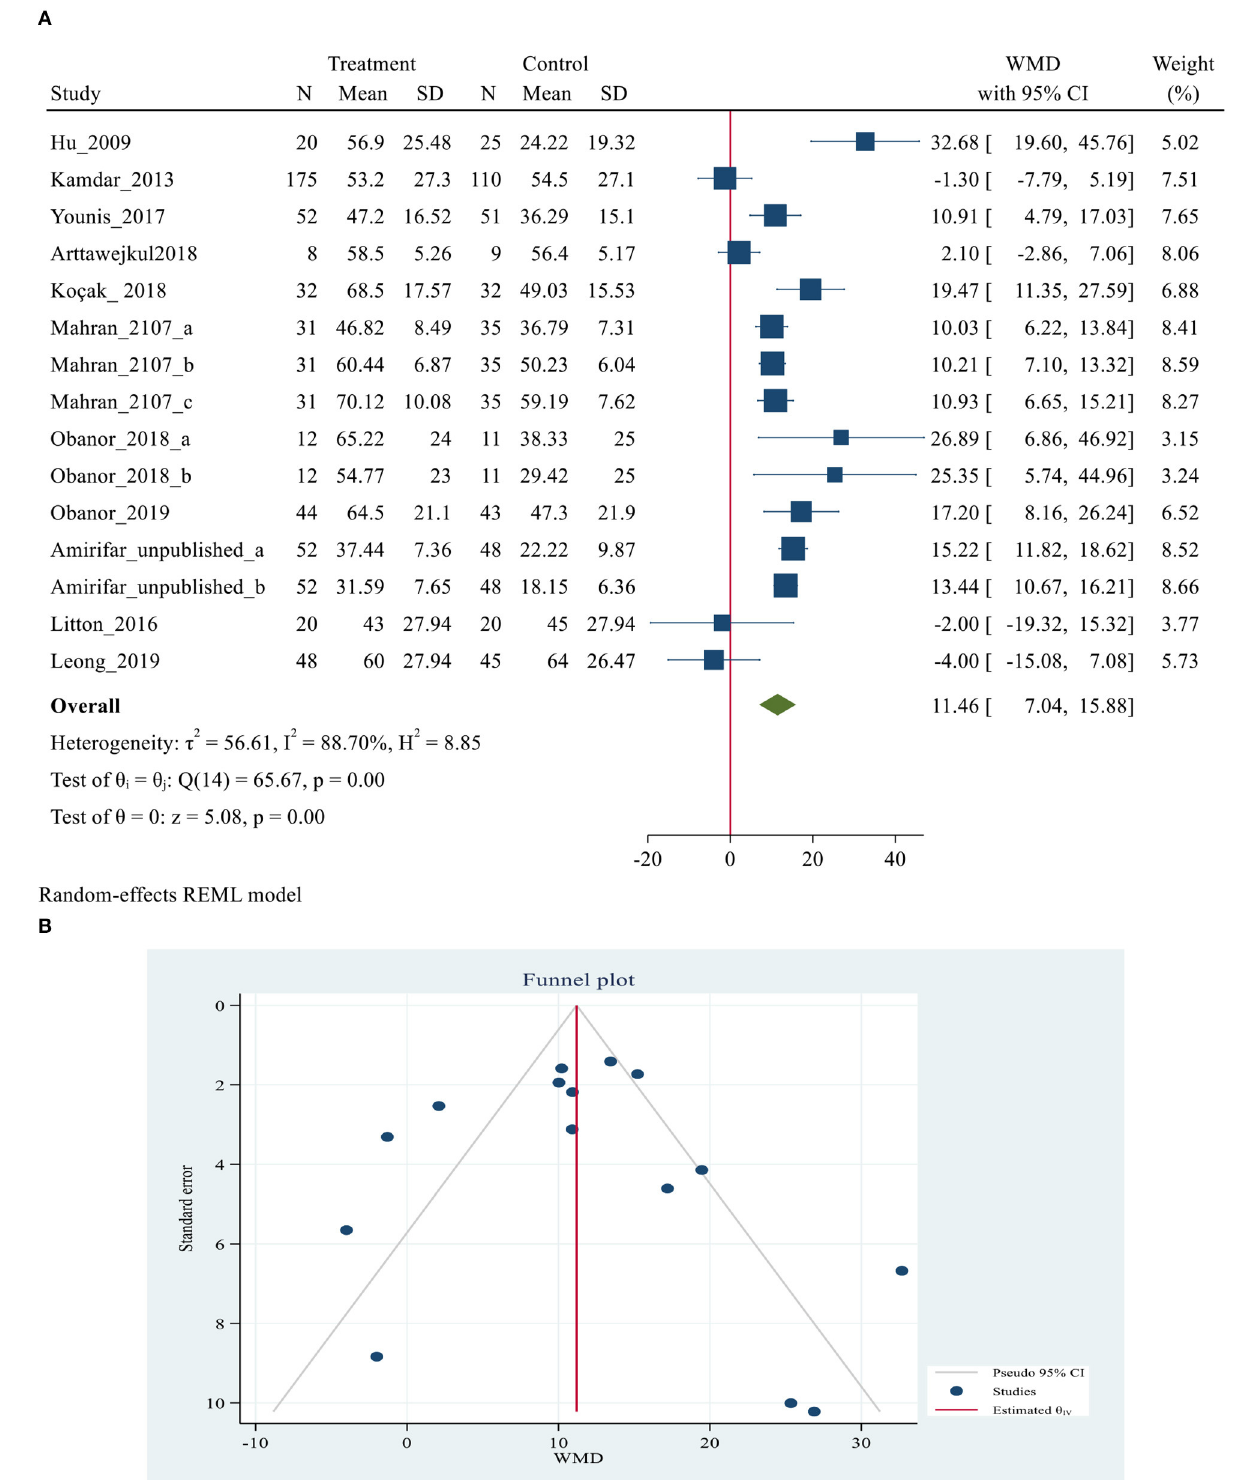
Frontiers in Psychiatry |